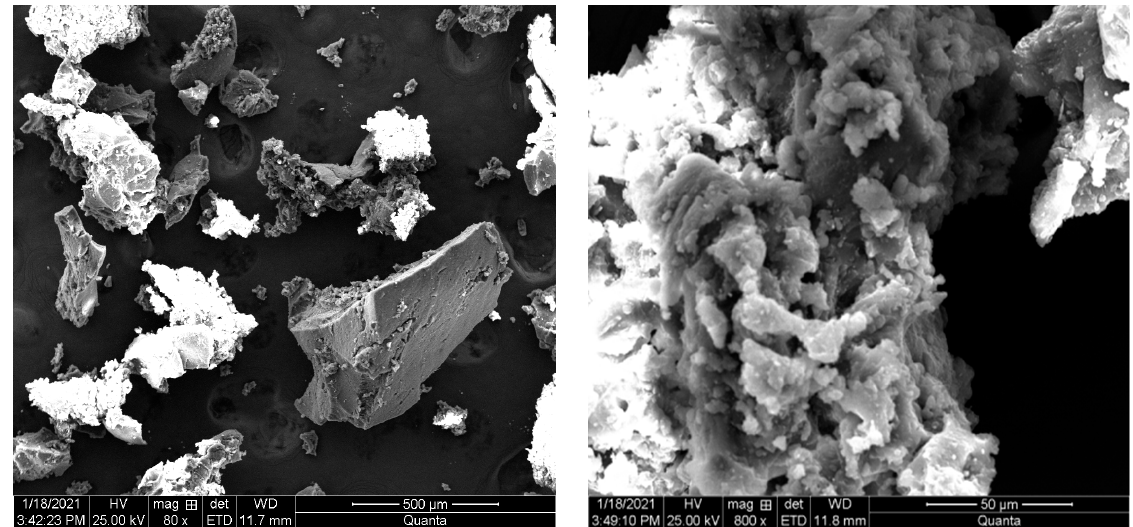
Figure 2. Micromorphology of rubber powder.